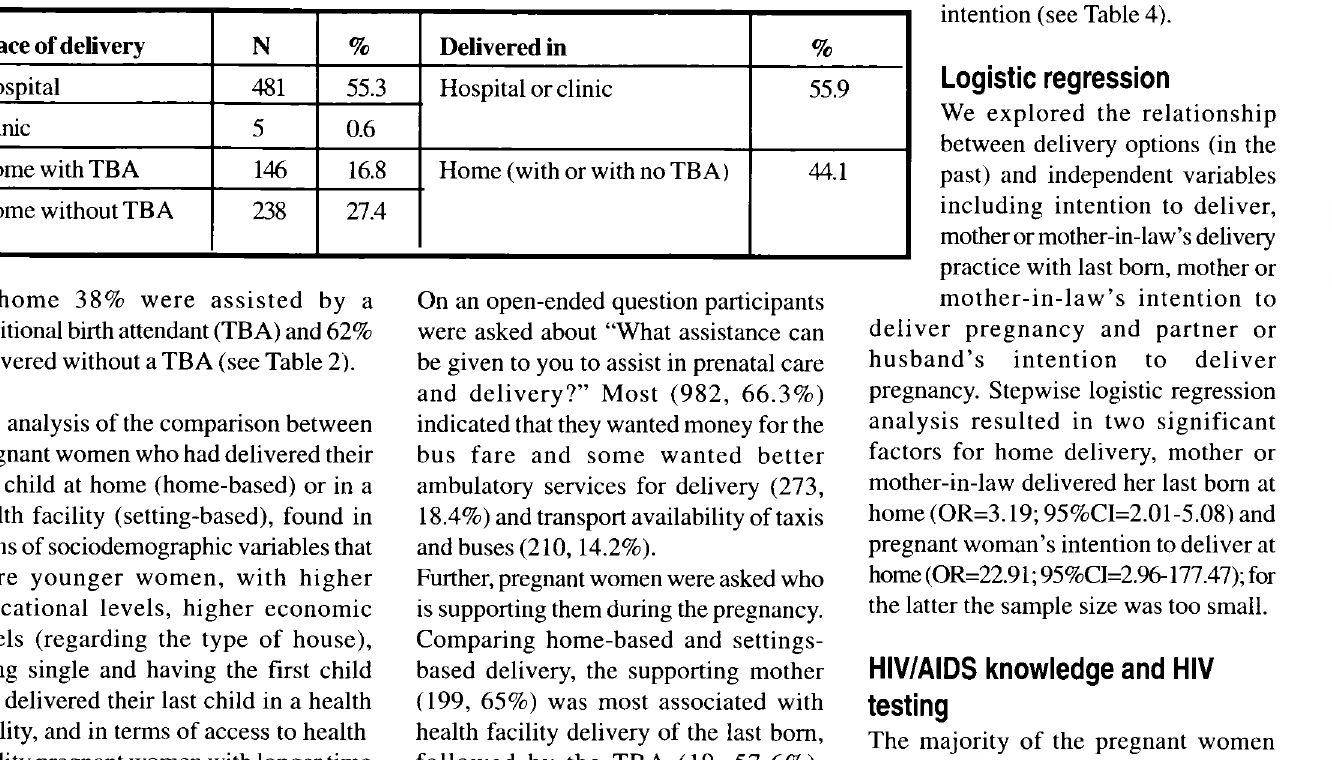
Table 2: Utilisation of delivery services among 870 mothers